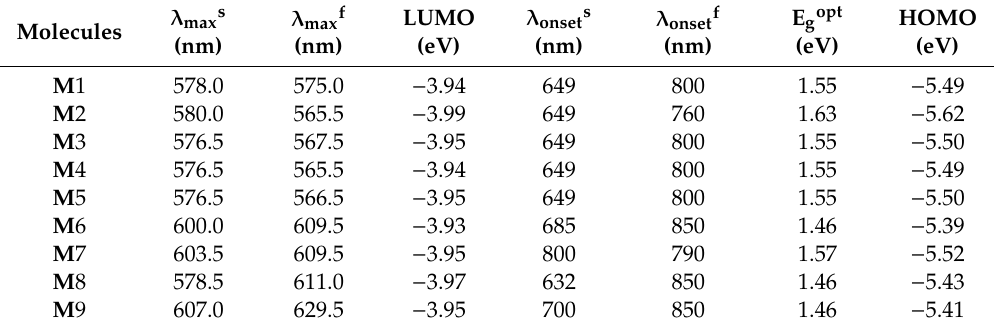
Figure 2. UV–vis spectra of meta -substituted phenyl-cored DPP molecules Ms1~5 and para -substituted phenyl-cored DPP molecules Ms6~9 ( b ) in CHCl 3 ( a , b ) and in films ( c , d ).